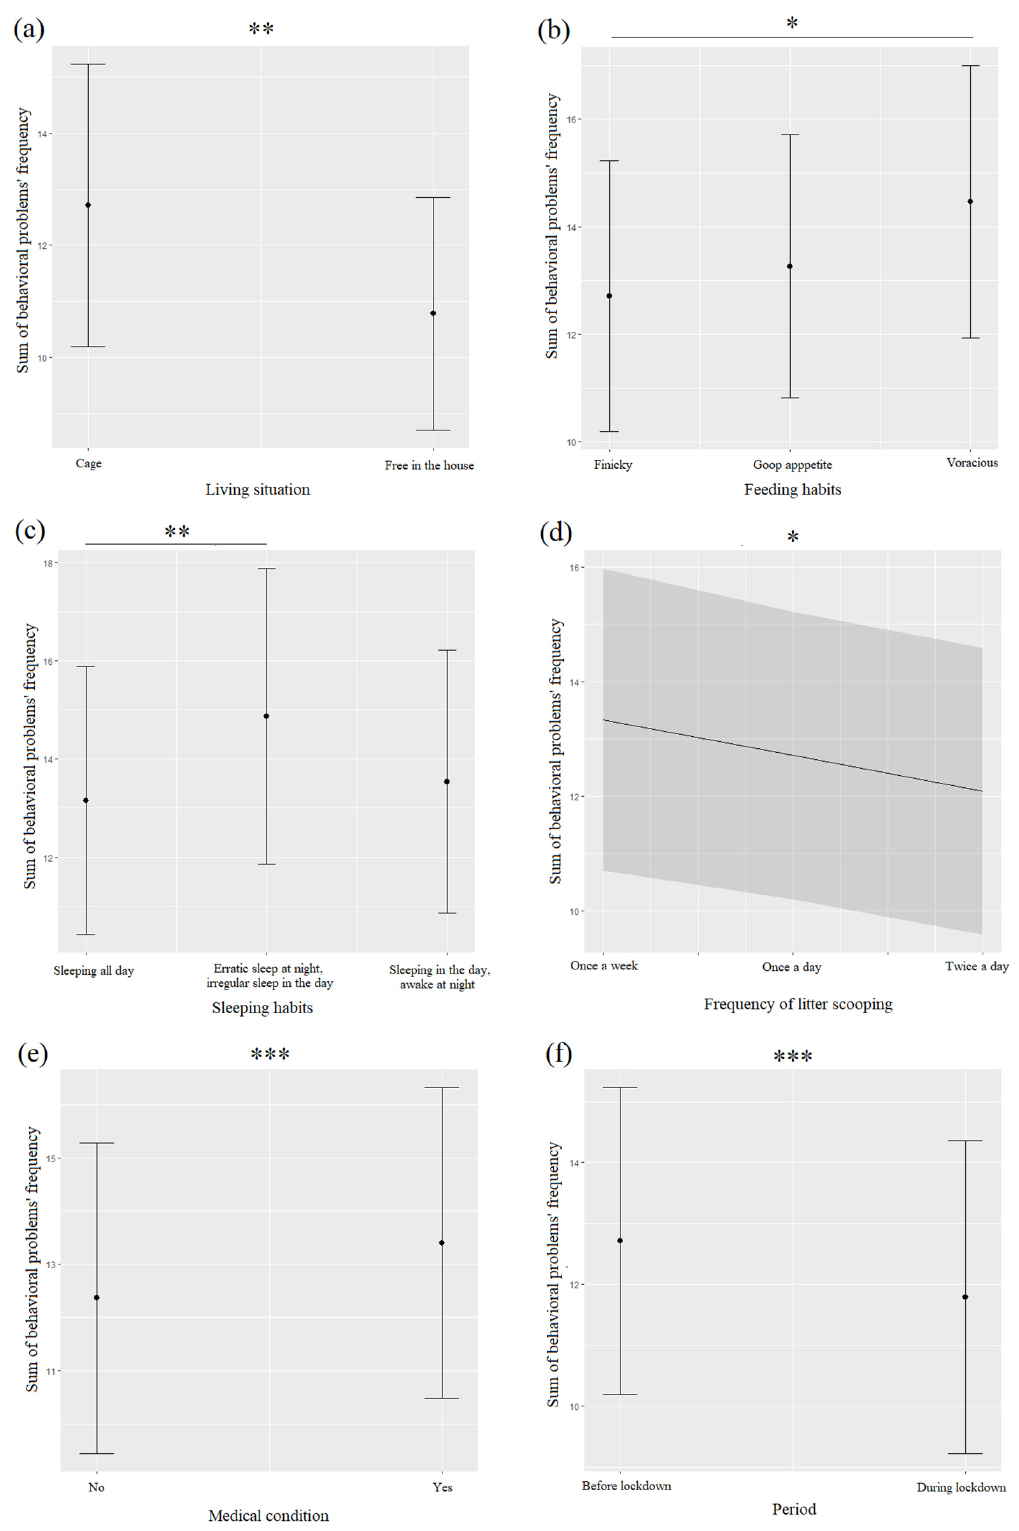
Figure 5. Means and 95% confidence intervals of cats’ behavioral problems frequency depending on cats’ living situation ( a ), feeding habits ( b ), sleeping habits ( c ), frequency of litter scooping ( d ), medical condition ( e ), and the period ( f ) extracted from linear mixed-effect models (LMMs). *: < 0.05; **: p < 0.01; ***: p < 0.001, Wald chi-squared tests with Bonferroni correction.